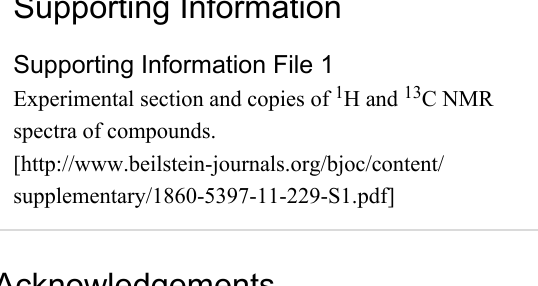
protocol attractive for academic research and practical applica- tions. Further studies towards the detailed mechanism and syn- thetic application of this protocol are in